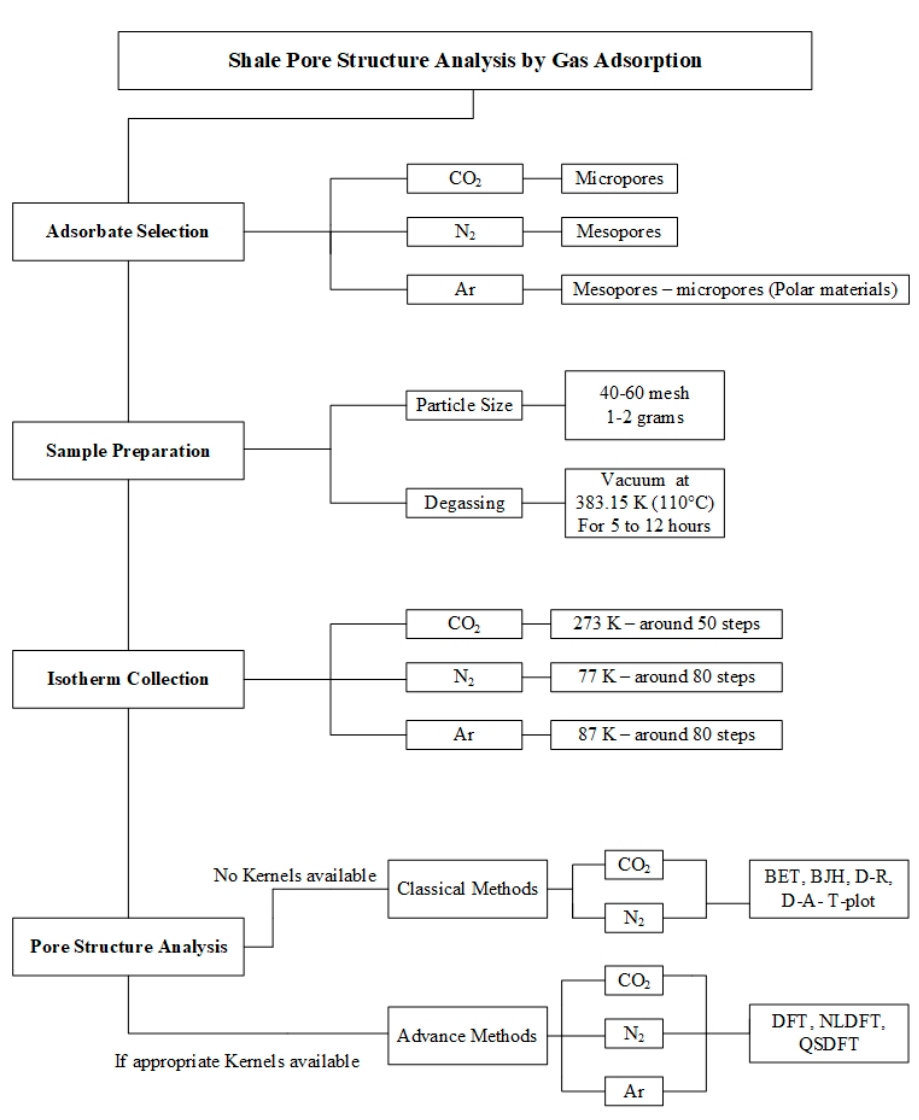
Figure 10. Diagram describing the common procedure to determine PSD of shales using gas ad ‐ sorption.